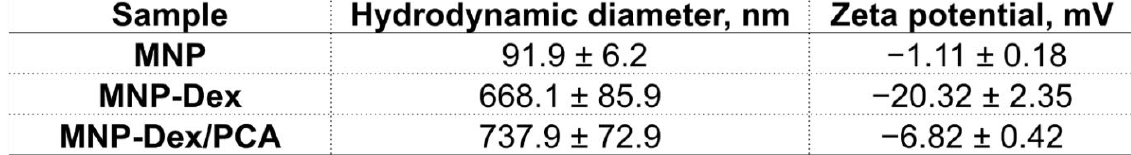
Figure 1. The schematic representation of MNP-Dex/PCA synthesis ( A ). Electron micrographs ( B ); representative measurements of average hydrodynamic diameter ( C ); and ζ -potential ( D ) of MNP, MNP-Dex, and MNP-Dex/PCA. Results reported as mean ± S.D. for 3 individual measurements ( E ).